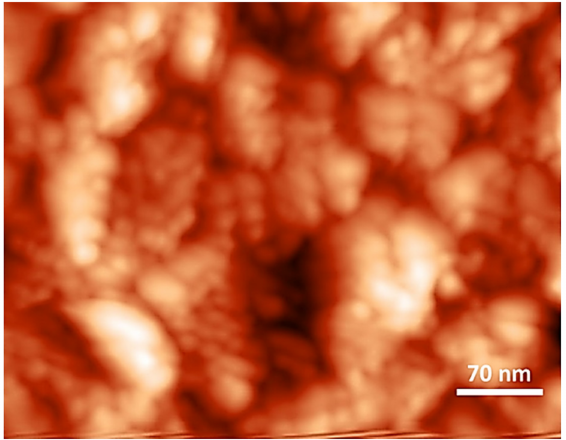
Figure 8. AFM topography at 2 µ m × 2 µ m of cellulose membrane (CM).